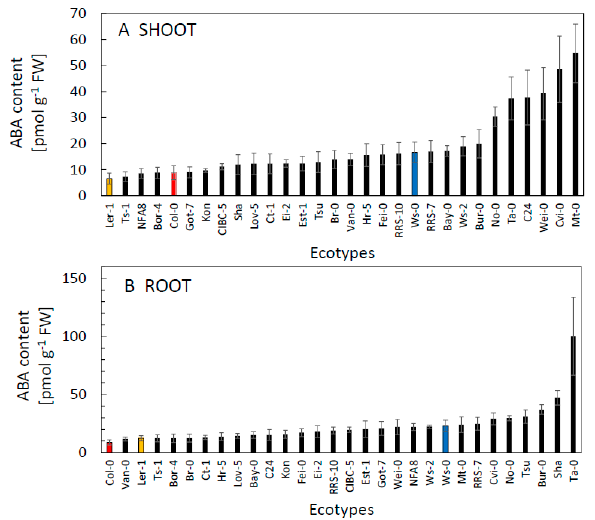
Figure 2. The content of IAA in the shoot ( A ) and root ( B ) of thirty A. thaliana ecotypes grown 21d in controlled conditions. Commonly used ecotypes are marked in colour (Red = Col-0, Blue = Ws-0, Orange = Ler-1). See Table 1 for the full list of ecotypes. Means ± SD.